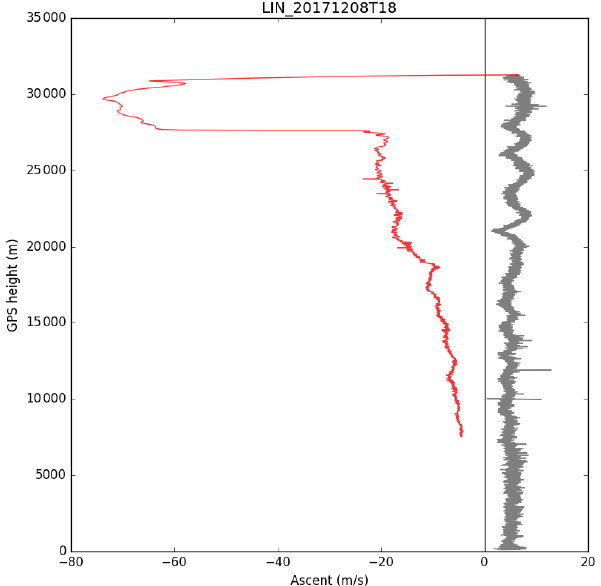
Figure 6. Mean descent rates for September–November 2019, showing the same categories as Fig. 2. For German profiles, an in- dication of the standard deviation (SD) has been